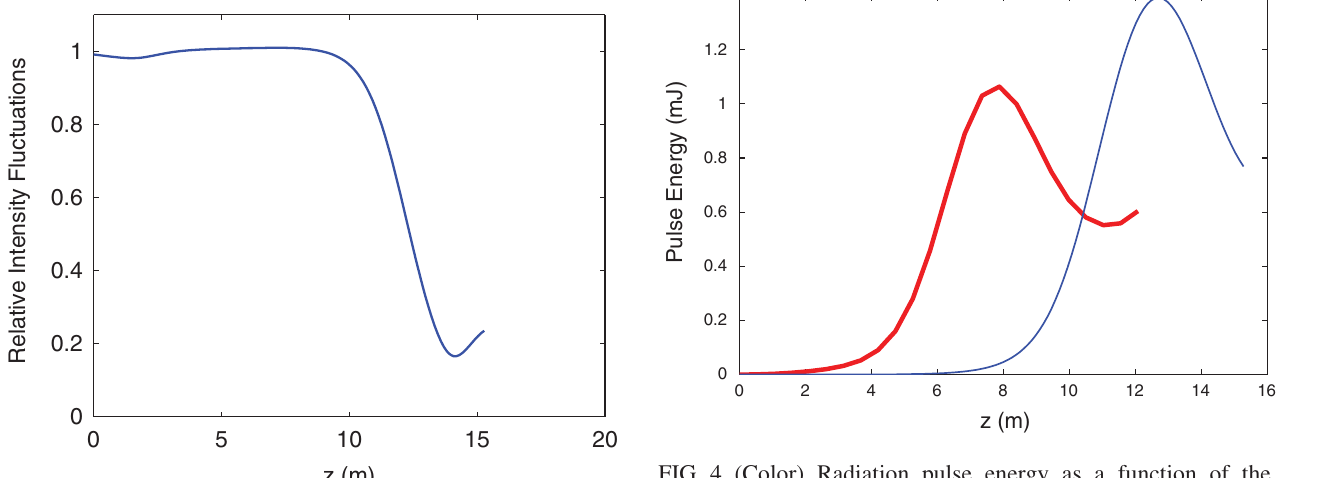
FIG. 4. (Color) Radiation pulse energy as a function of the position along the second undulator for the self-seeding (blue line) and for the HGHG (red thick line). The results for the self- seeding are averaged over 20 independent simulations.